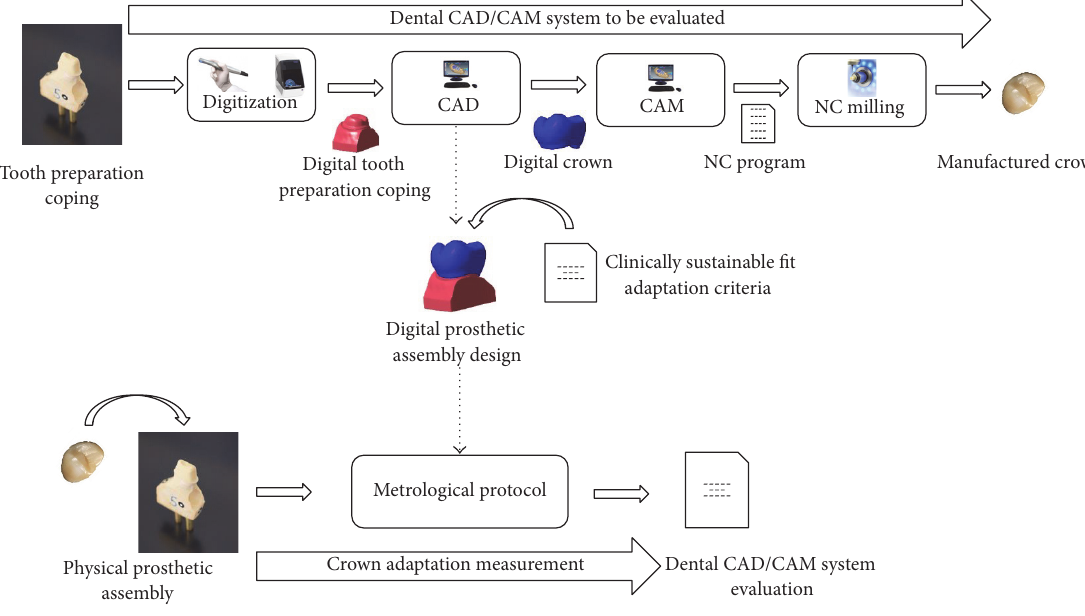
Figure 1: Dental CAD/CAM assessment